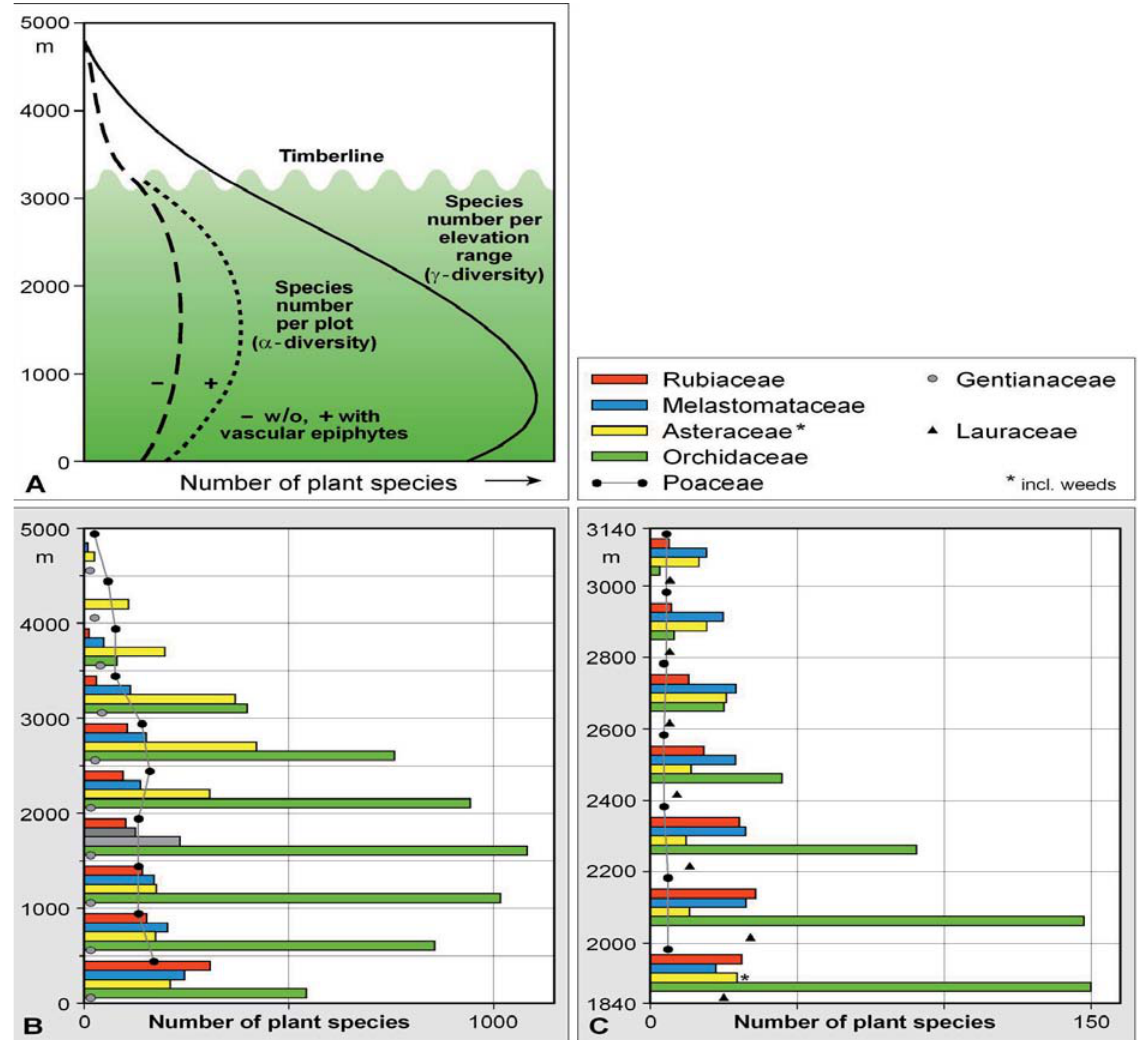
Figure 5: (A) Idealised altitudinal change of vascular plant ?- and ?-diversities in tropical mountains (from: Richter 2001, modified); species richness peaks at medium elevations (Mid-Domain-Effect). (B) Discordant vertical dis- tribution of species numbers of selected plant families in Ecuador (data extracted from Jørgensen & León-Yanez 1999); (C) same as B, but only for the RBSF area (data from Homeier & Werner 2008 and Diertl